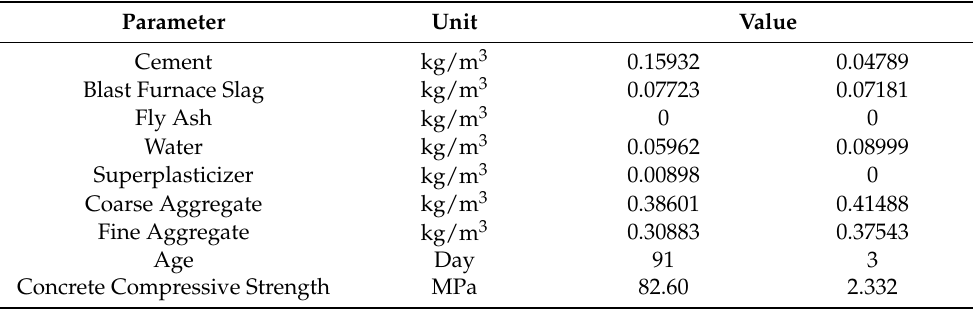
Table 8. The highest and lowest predicted recycled aggregates compressive concrete